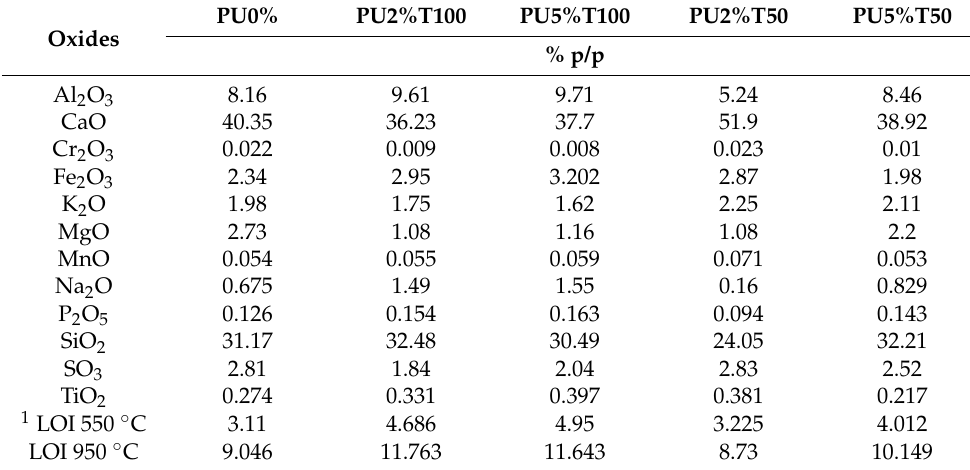
Table 4. Quantification of oxides present in the samples determined by X-ray